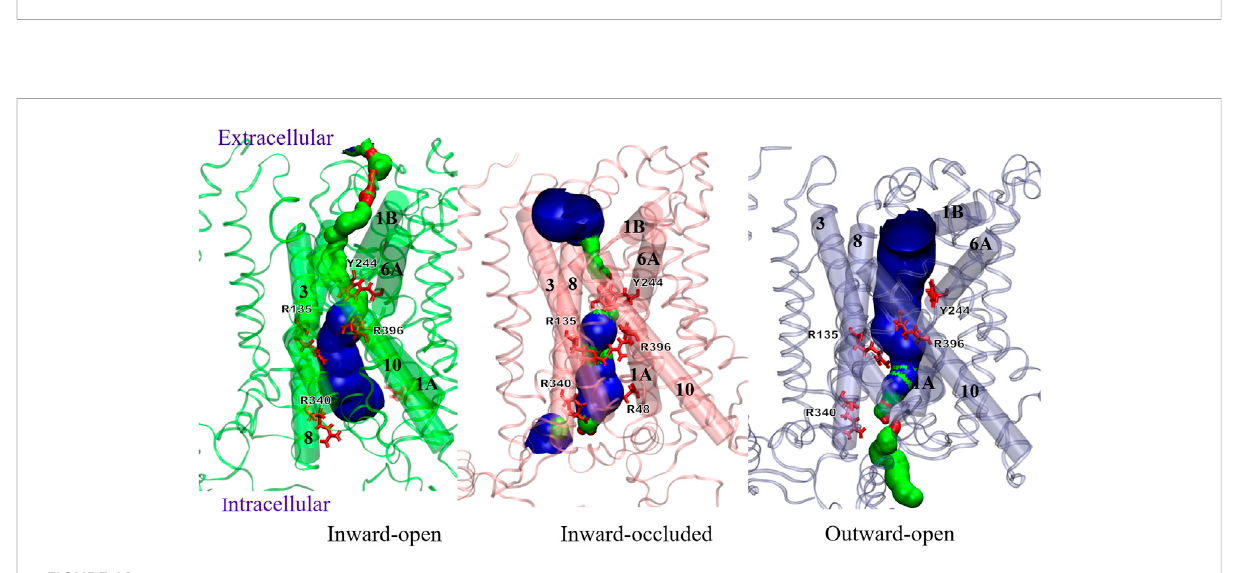
FIGURE 10 Comparison of Sxc-pore pro fi les in different conformations using the HOLE